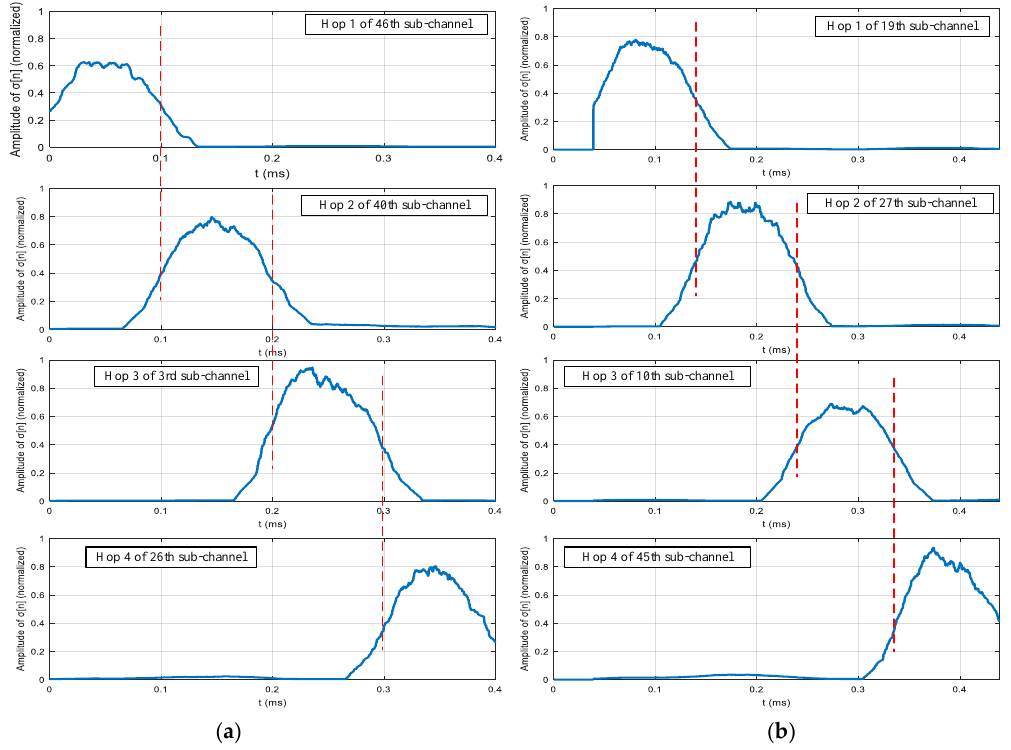
Figure 5. Results of signals tracking: ( a ) source 1; ( b ) source 2. Appl. Sci. 2019 , 9, x FOR PEER REVIEW